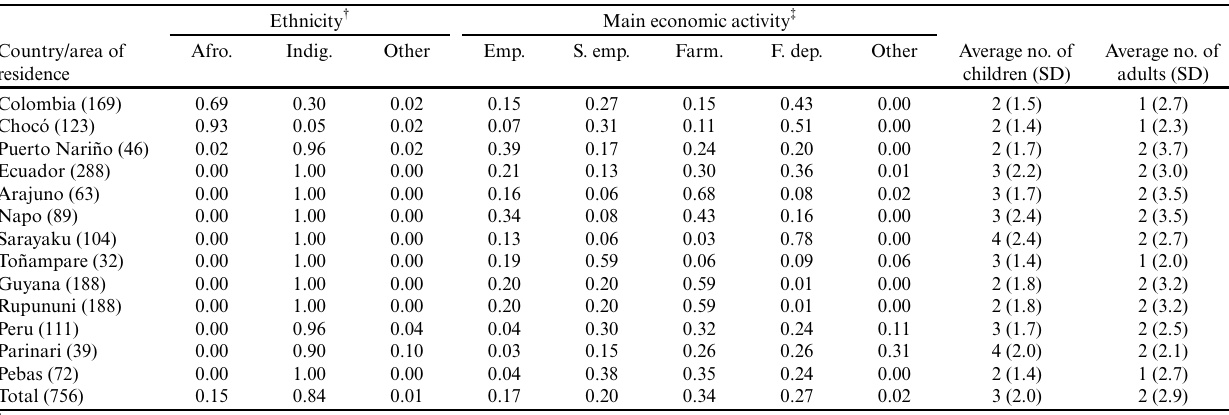
Average no. of children (SD) adults (SD)